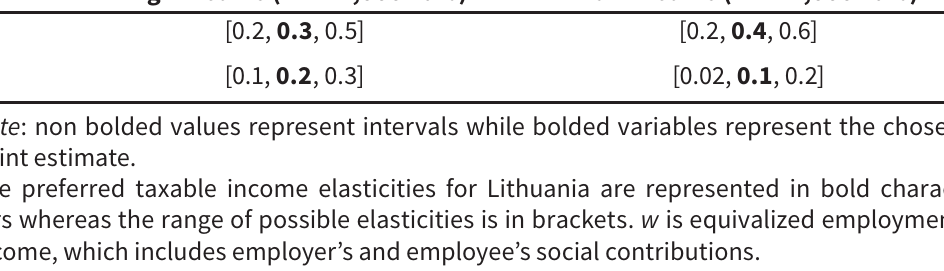
Ranges of elasticities of taxable income for Lithuania